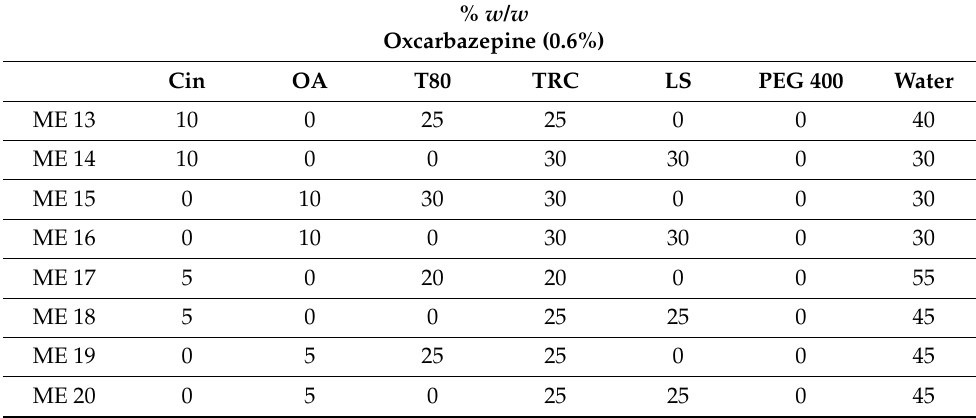
Table 2. Composition of microemulsions